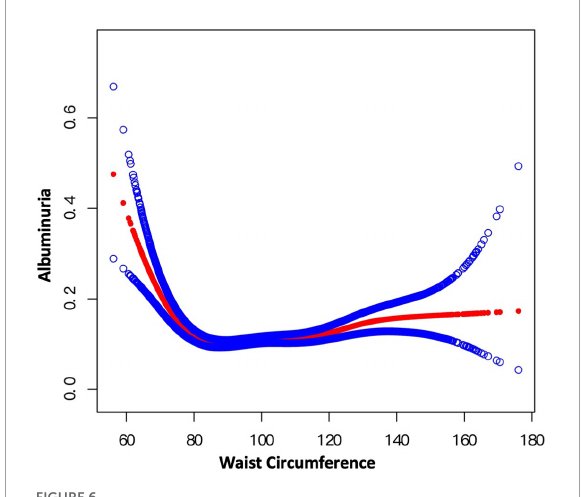
FIGURE6 Smooth curve fitting for WC and albuminuria. Non-linear relationship between WC and albuminuria was detected by the generalized additive